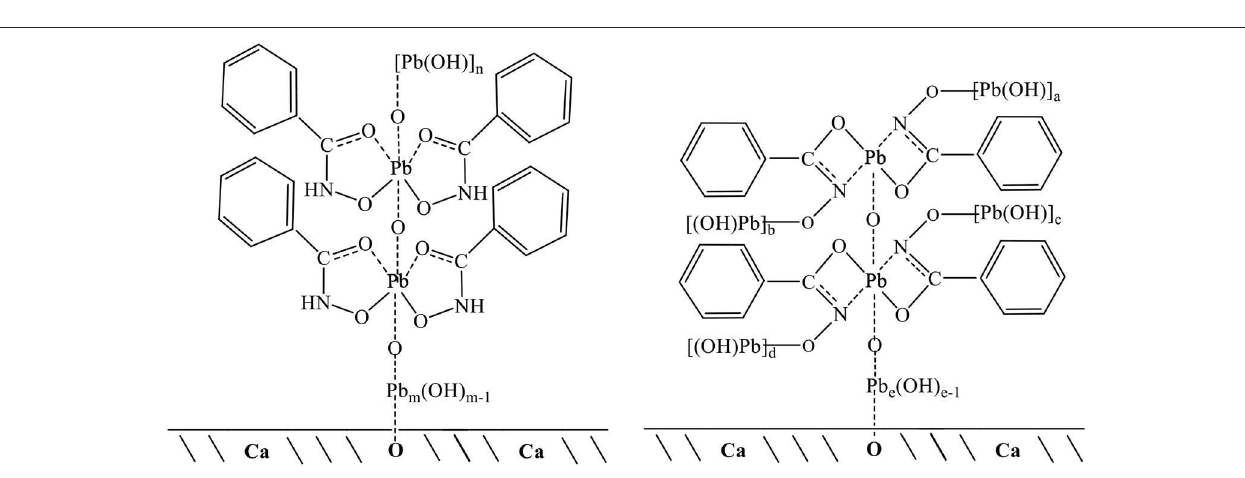
FIGURE 10 | Possible structures of Pb-BHA complexes adsorbed on scheelite